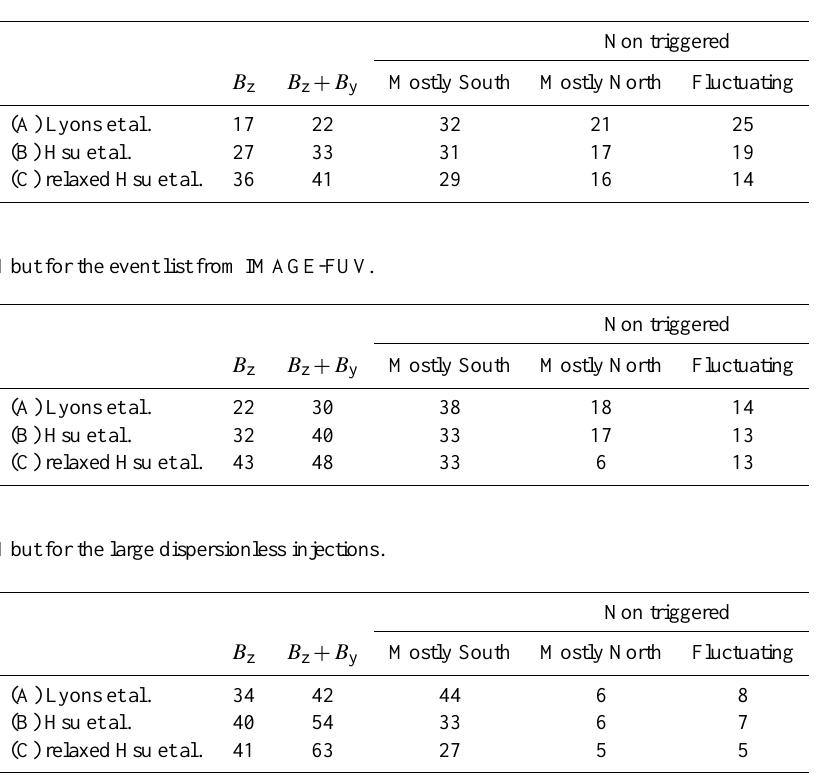
Table 1. Percentages of IMF triggering for the THEMIS events. The first row (A) represents the results applying the Lyons et al. criteria. The second row (B) provides the triggering percentage applying the Hsu et al. visual criteria. The third row (C) shows the results applying the same criteria used in row (B) but without requirements for the preceding IMF B z . The values in the tables represent percentages.